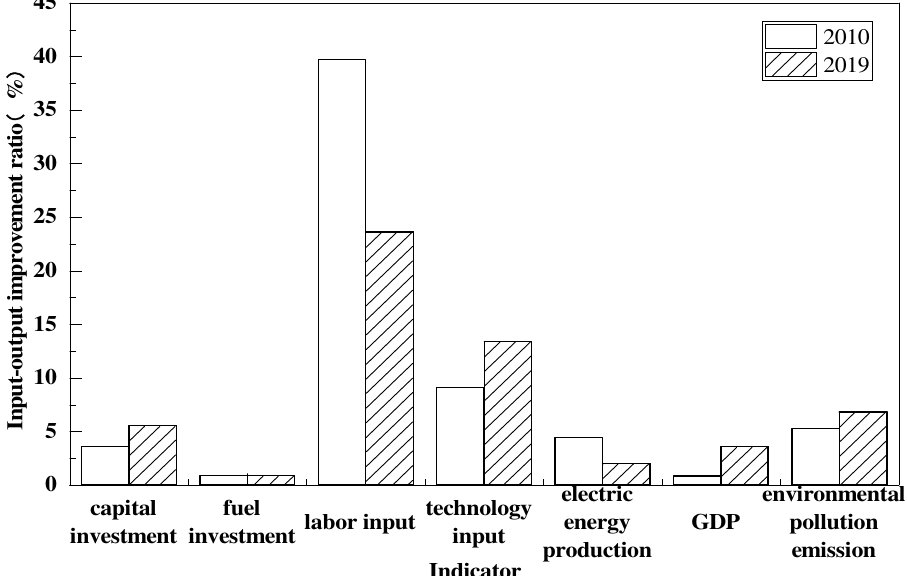
Figure 3. Percentage improvement of each indicator in 2010 and 2019 .